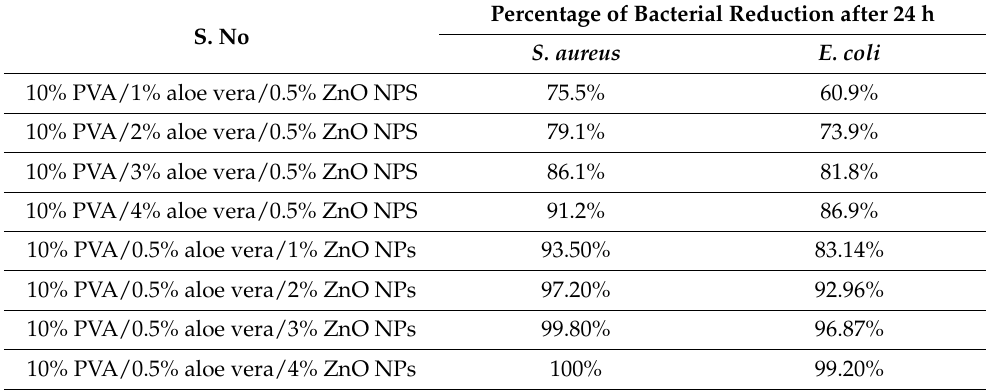
Table 2. Antimicrobial activity of all electrospun samples with variation in aloe vera and ZnO NPs against S. aureus and E. coli [102].